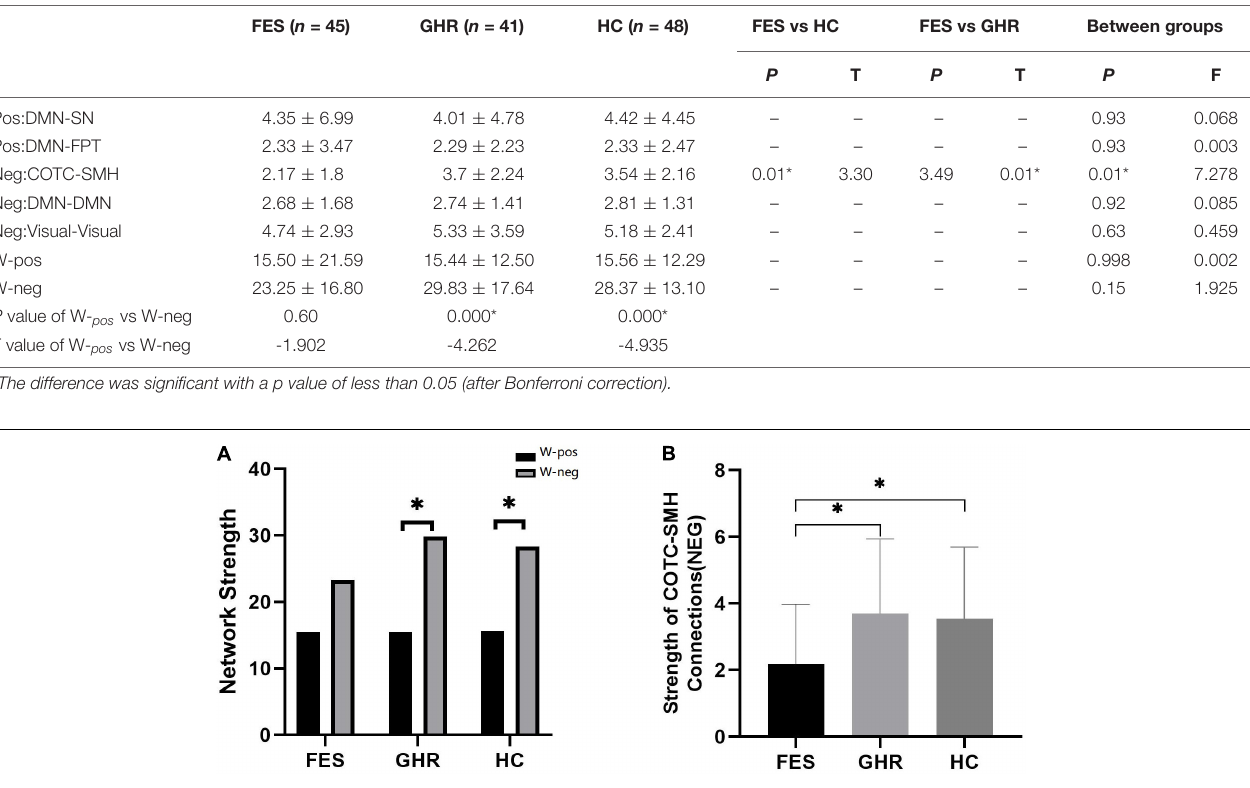
FIGURE 3 | Comparison of positively and negatively associated network strengths and the decreased connectivity of the Cingulo opercular task control (COTC)-sensory/somatomotor hand (SMH0 network. (A) Negatively associated network strength was significantly higher than positively associated network strength in HCs ( p < 0.001) and GHR ( p < 0.001). (B) The strength of negatively associated connections in the COTC-SMH network in FES was significantly decreased as compared to GHR ( p = 0.005) and HC ( p = 0.015). *The difference was significant with a p value of less than 0.05 (after Bonferroni